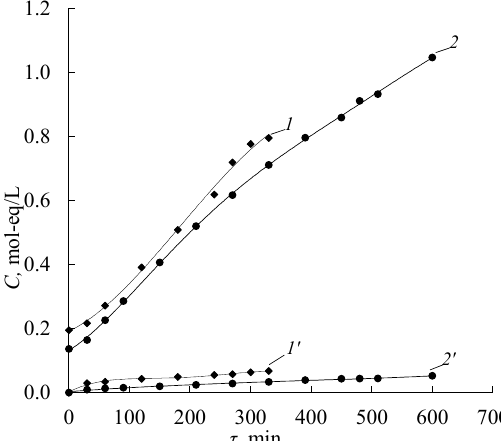
Figure 17. Dependence of the concentrations of sulfuric acid ( 1 , 2 ) and diethylammonium sulfate ( 1’ , 2’ ) in the solution circulating through the acid compartments of the electrodialyzer on the operating time using as anion-exchange membranes: 1 , 1’ —MA-40L, 2 , 2’ —Ralex AMH. The solid lines show the approximating curves.